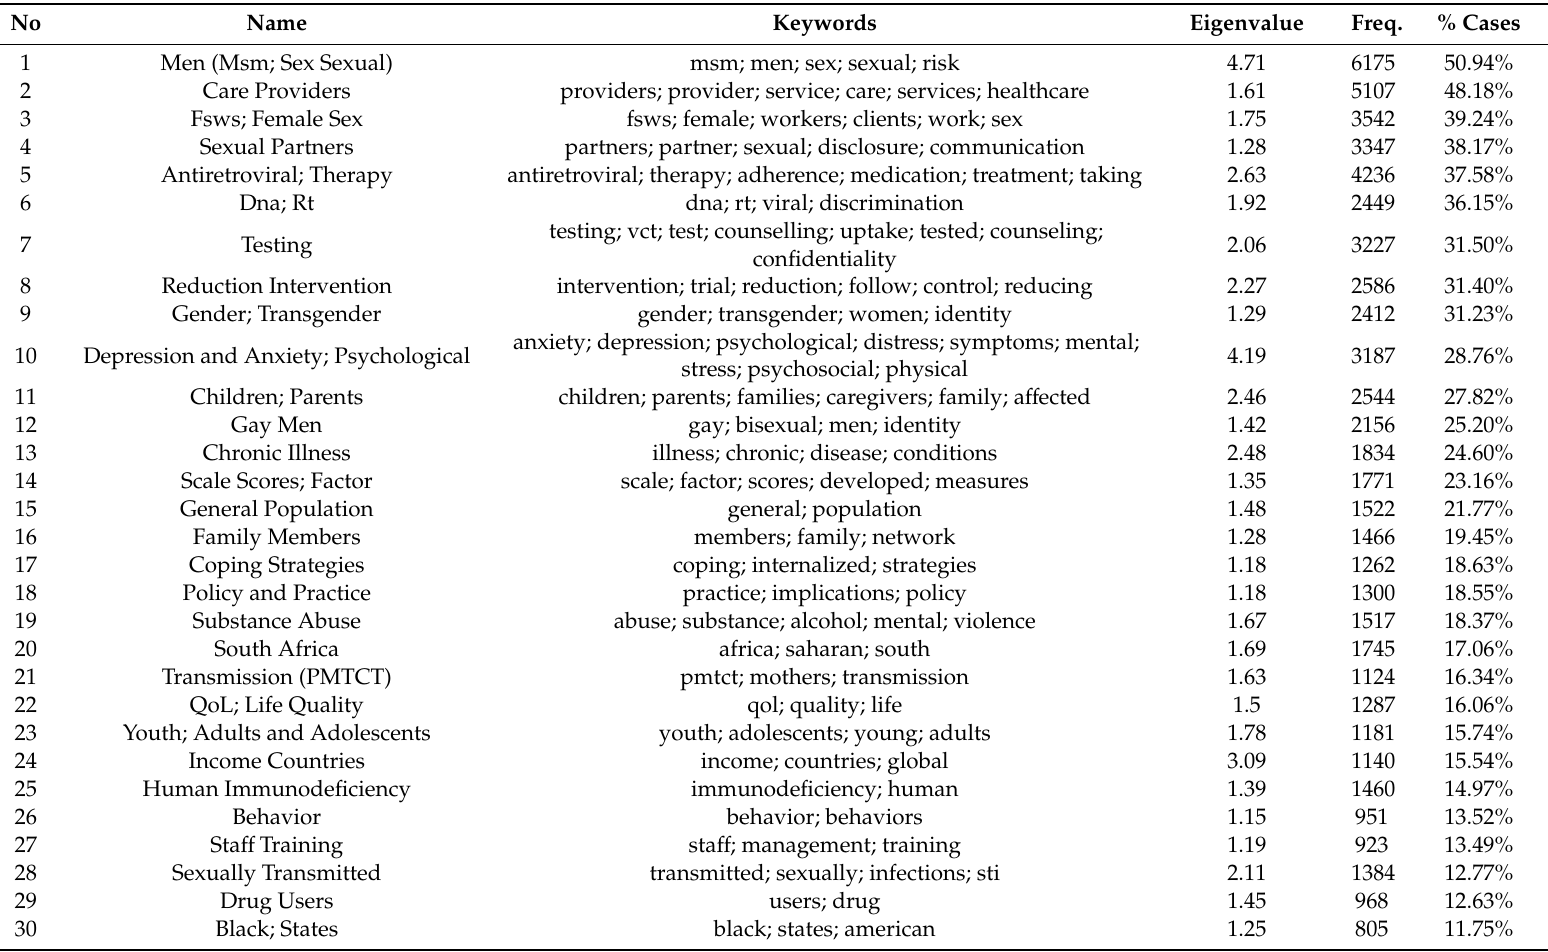
Table 4. Top 50 research domains emerged from exploratory factor analysis of all abstracts’